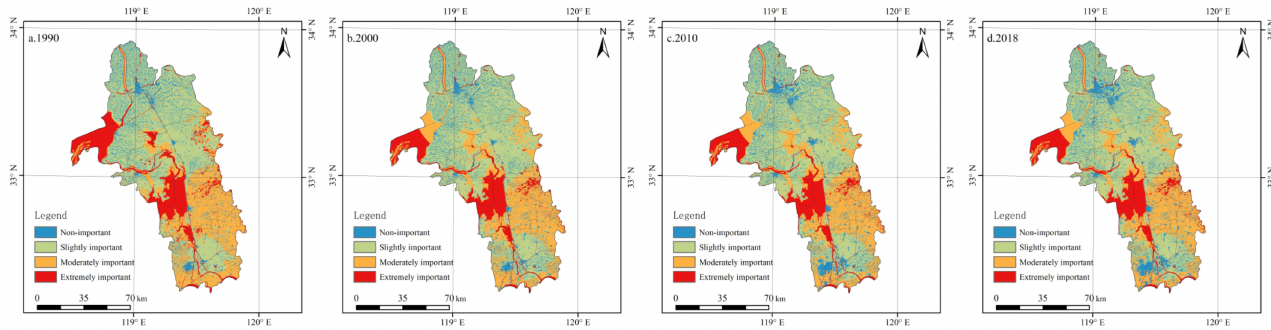
Figure 4. Spatial distribution of each ecosystem service in the Huaiyang Canal from 1990 to 2018 (Note: ( A ) water conservation service; ( B ) soil conservation service; ( C ) carbon sequestration service; ( D ) biodiversity conservation service).